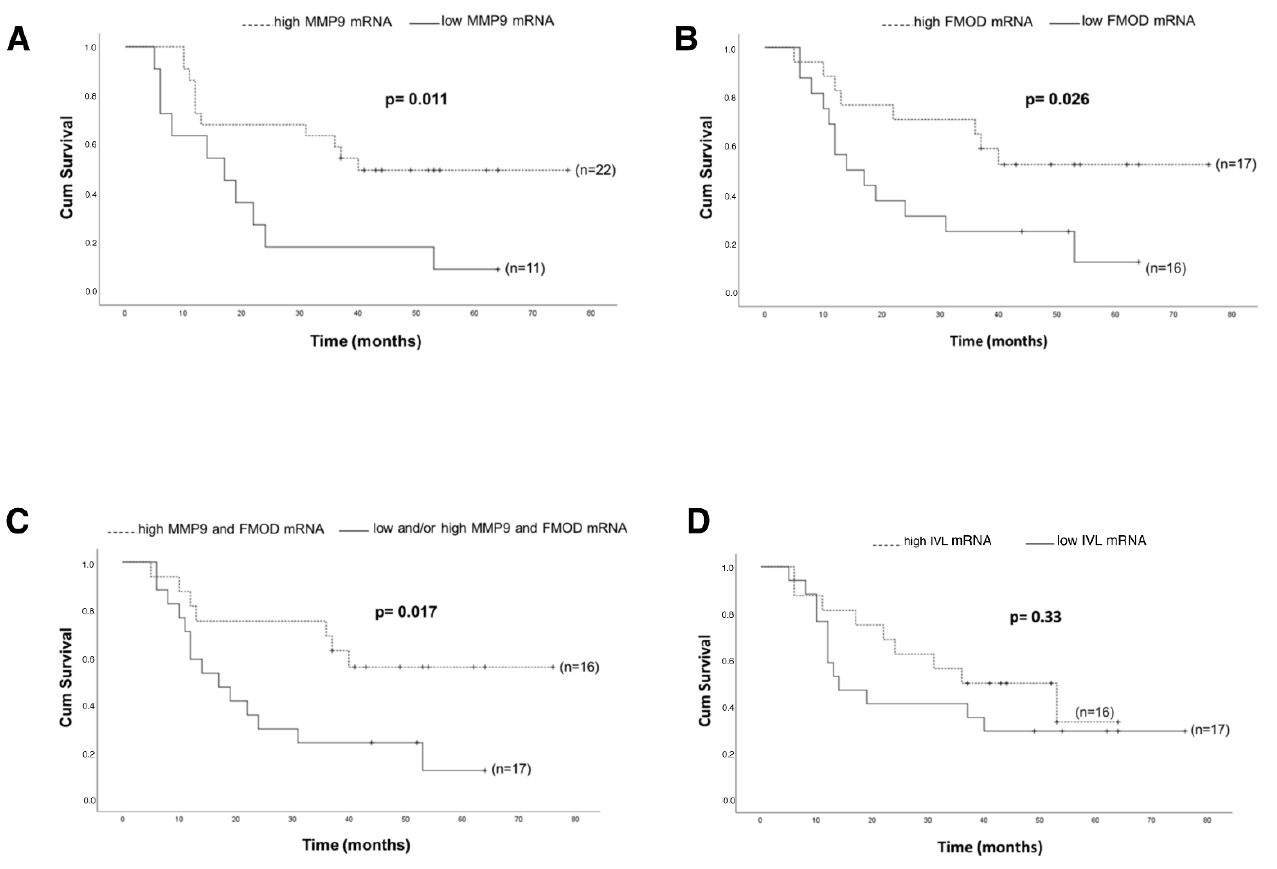
Figure 6. Kaplan–Meier log-rank survival analysis of HNSCC patients with regard to different mRNA expressions. ( A ) MMP9 ; ( B ) FMOD ; ( C ) MMP9/FMOD ; ( D ) IVL .